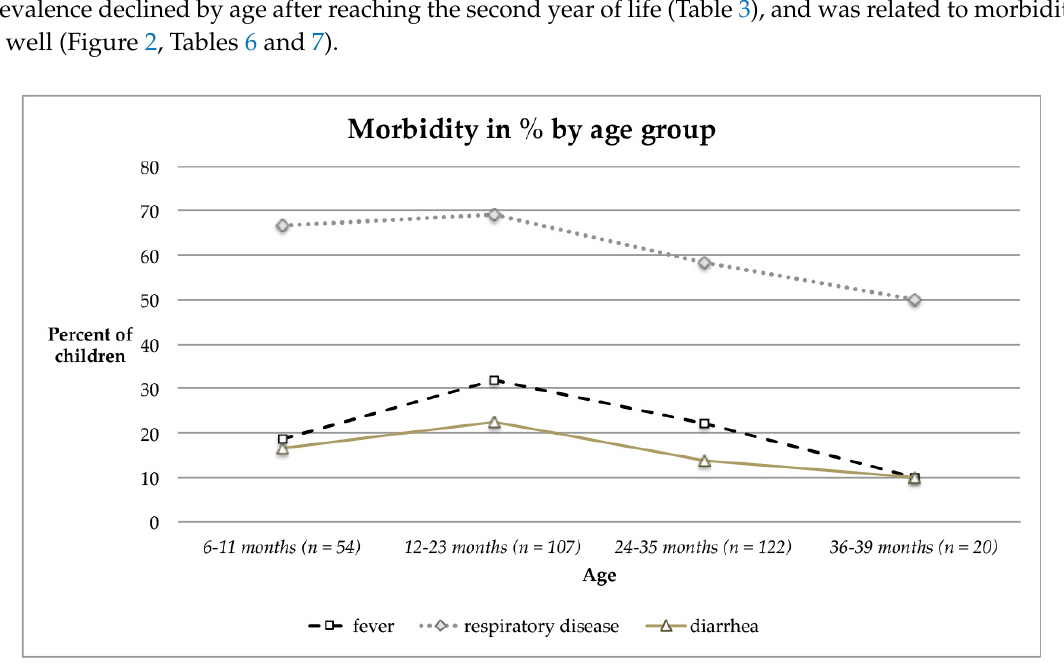
Figure 2. Proportion (%) of children ( n = 303) by anemia status suffering from fever, respiratory disease or diarrhea during the last week prior/or during medical checkup. Still, when considering age-related trends of morbidity or morbidity prevalence by anemia status the small sample size for the oldest age group (36–39 months) and the category “severe anemia” has to be taken into account. In particular for Figure 2 a steady rise of morbidity rates by increasing severity of anemia was presumed. No significant differences in morbidity by sex were found. 3.2.6. Health Access and Health Seeking Behavior Despite the depicted tense undernutrition situation, the vast majority of mothers (87.2%, n = 282) perceived her child as “active” (playing, laughing and speaking). Merely every tenth mother said her